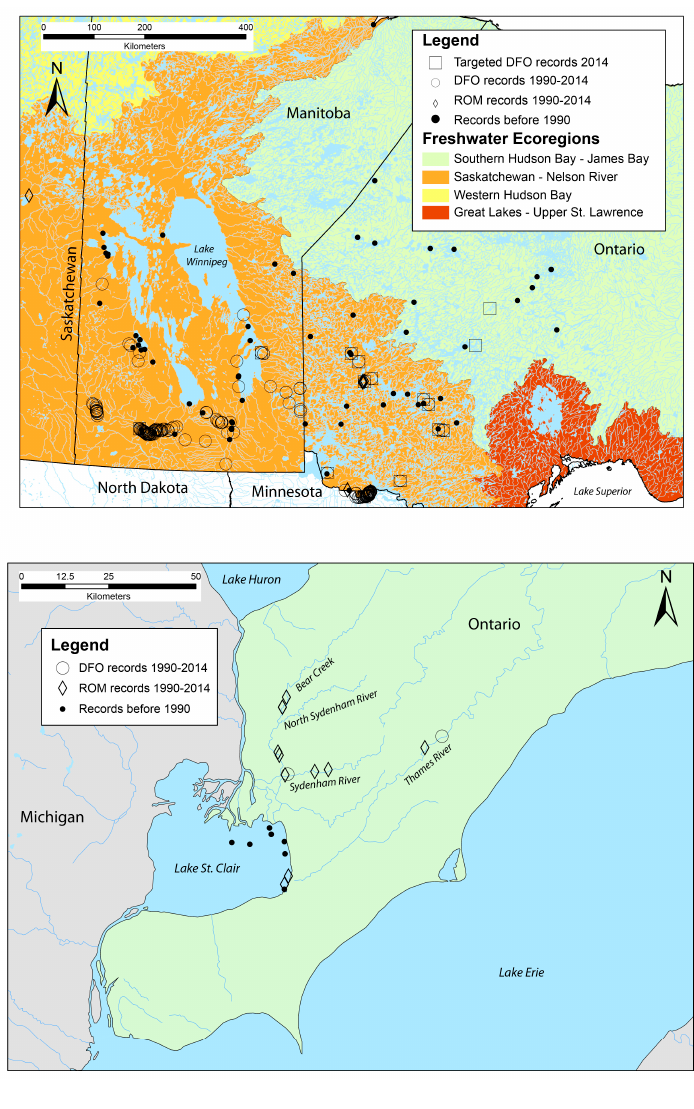
Figure 1. Locations of historic (pre-1990; solid circle), Royal Ontario Museum (ROM) (1990–2014; open diamond), Fisheries and Oceans Canada (DFO) incidental (open circle) and DFO targeted (open square) River Darter collections. The top panel displays collections from the Saskatchewan-Nelson and Southern Hudson Bay-James Bay ecozones in Manitoba and northwestern Ontario, while the lower panel displays collections in southern Ontario from the Great Lakes-Upper St. Lawrence ecozone.